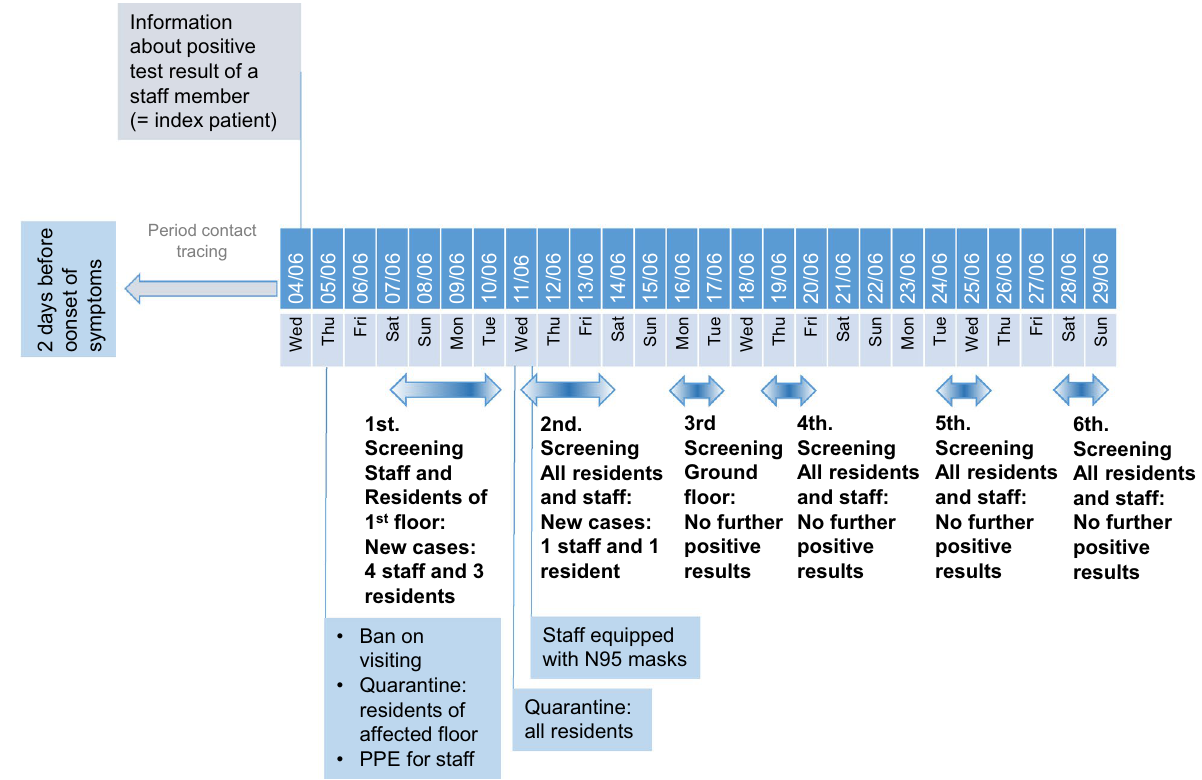
Figure 2. Timeline of events and directed measures in nursing home NH02. Graphical representation of the chronological sequence of screenings, new infections, deaths and measures taken to contain the outbreak.